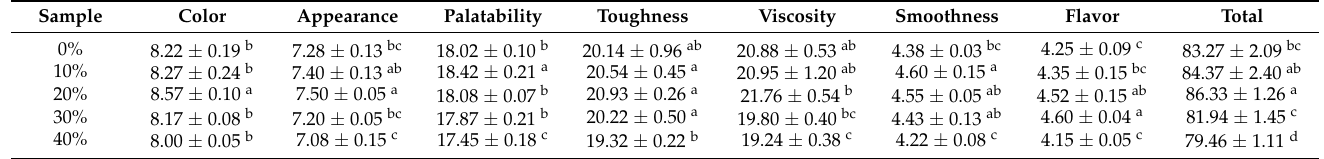
Table 8. Sensory properties of ginkgo biloba